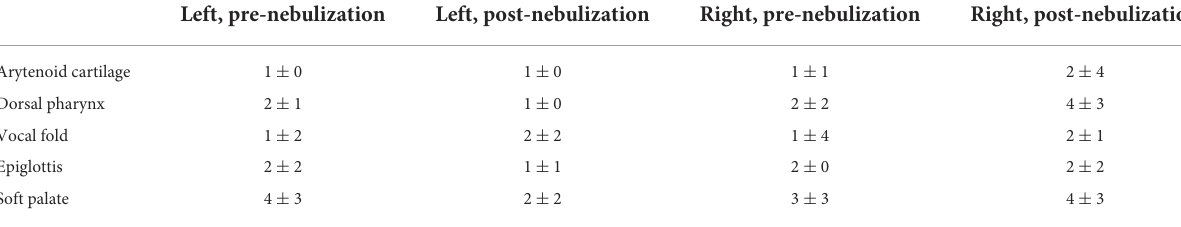
TABLE 2 Number of probes required to stimulate swallow response before and after nebulization with 1 mg/kg 4% Lidocaine.